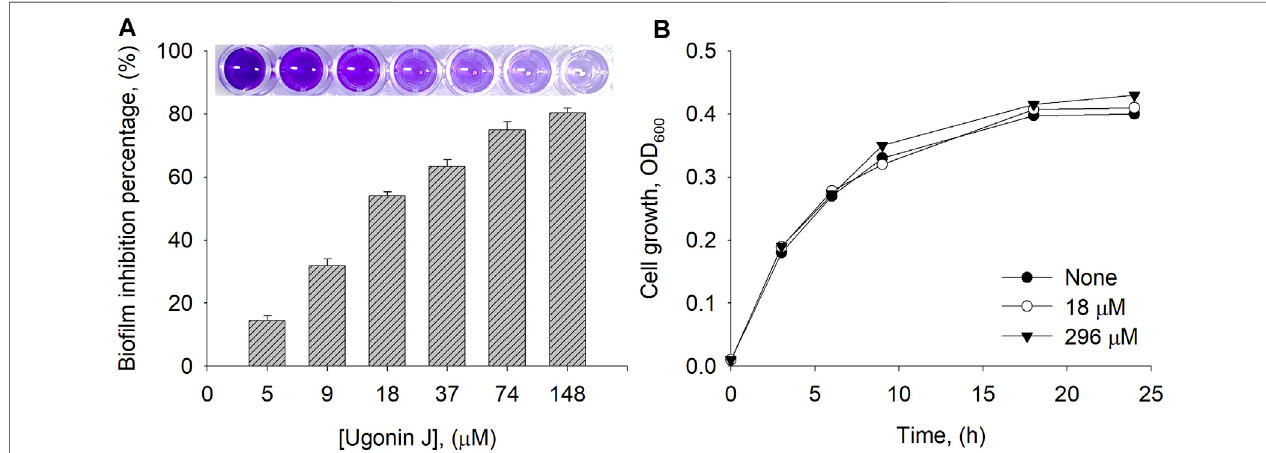
FIGURE 5 | (A) Bio fi lm inhibition percentage by compound 1 at different concentrations (B) Cell growth of E. coli measured at 0, 18 and 296 µM of 1